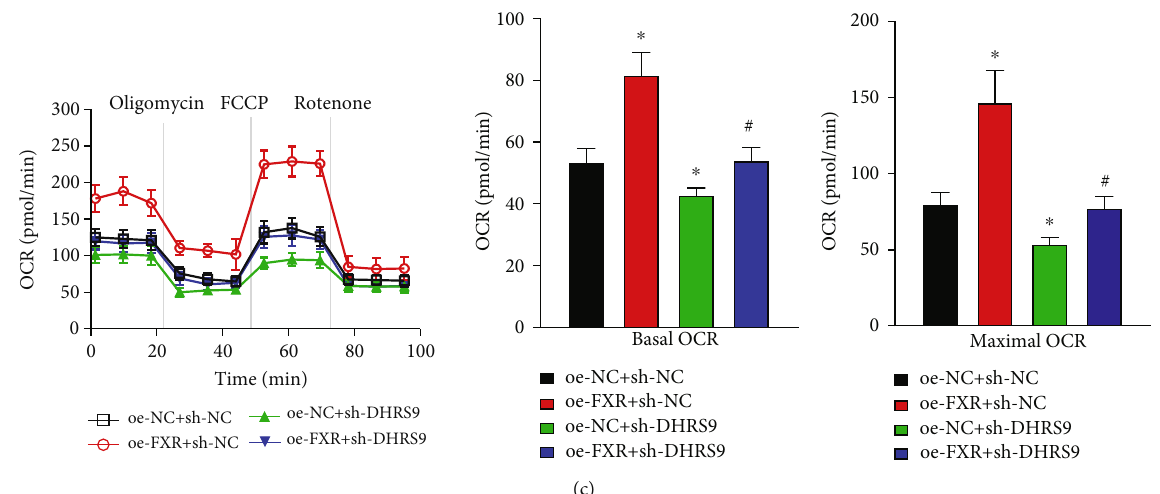
Figure 5: FXR activates DHRS9 to inhibit oxidative phosphorylation in colon cancer. (a) The enrichment diagram of the KEGG pathway analysis on DHRS9 gene. (b) The protein expression of oxidative phosphorylation-related genes in cells demonstrated by Western blot. (c) OCR values of di ff erent transfection groups. ∗ vs. oe-NC+sh-NC; # vs. oe-FXR+sh-NC ( ∗ or # denote P < 0 : 05